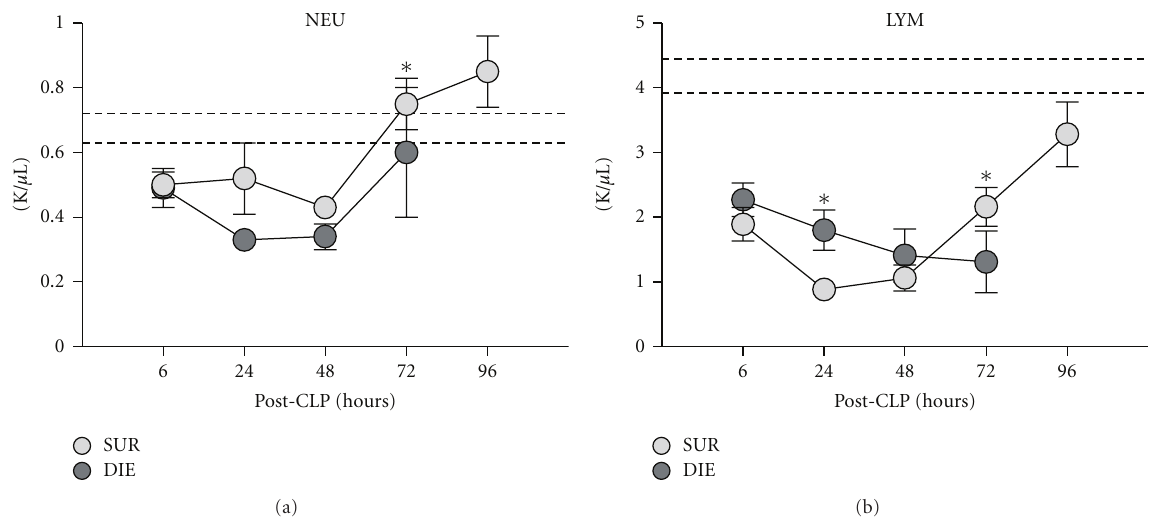
Figure 7: Retrospective comparison of neutrophil and lymphocyte count in dying (DIE) versus surviving (SUR) animals after-CLP. 3- month-old female mice were subjected to trauma/hemorrhage followed by polymicrobial CLP-induced sepsis. Displayed values were compared between DIE and SUR groups 6 h (DIE n = 31, SUR n = 33), 24h (DIE n = 29, SUR n = 34), 48h (DIE n = 18, SUR n = 32), 72h (DIE n = 12, SUR n = 32), and 96 h (SUR n = 28) after-CLP. Dotted lines represent normal values. ∗ P < .